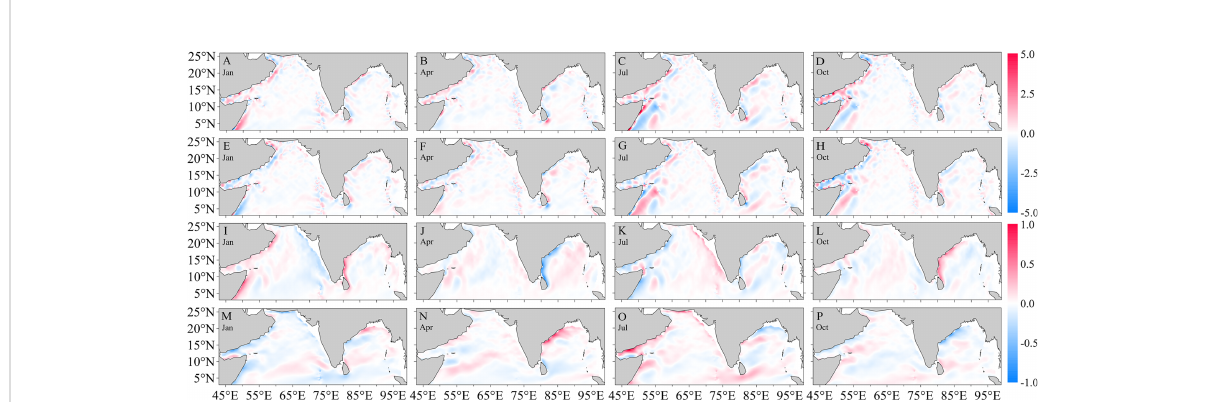
FIGURE 7 The distribution of ∂ (cid:2) u = ∂ x (A-D) and ∂ (cid:2) v = ∂ y (E-H) in January, April, July, and October (unit: 10 -6 s -1 ); the distribution of ∂ ~ r = ∂ x (I-L) and ∂ ~ r = ∂ y (M-P) in January, April, July, and October (unit: 10 -5 kg·m -4